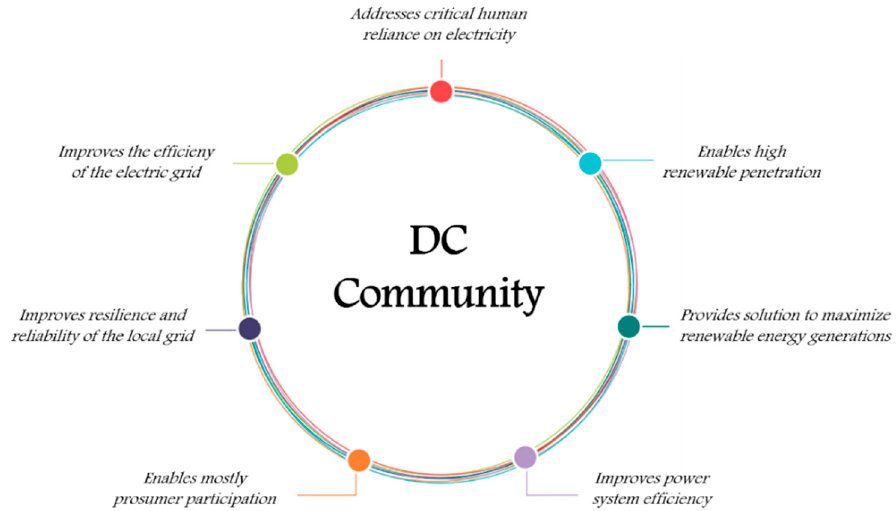
Figure 2. Characteristics of the DC community. DC-COM provides better coordination and allocation of resources. DC-COM has many design advantages at the community level that include the phases of planning, operation, and control.